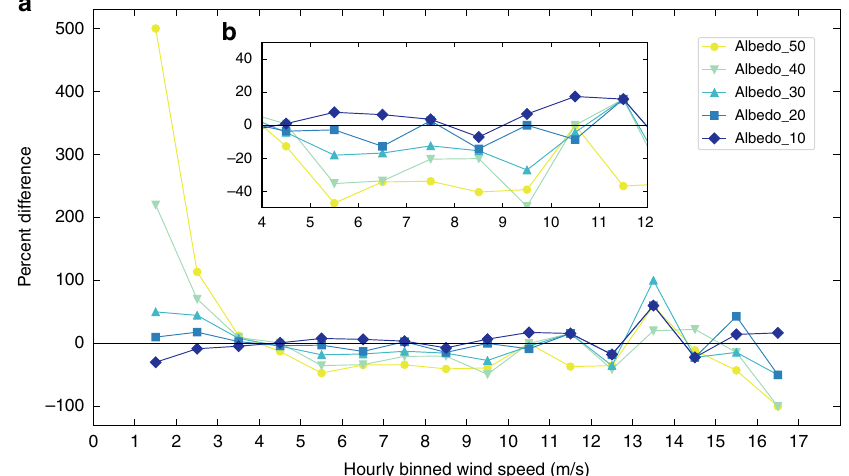
Fig. 5 Percent difference of wind speed frequencies between the albedo simulations and control. a The percent difference of spring (March, April, and May) 2011 hourly 10-m wind speed frequency (averaged for the entire Hami Basin) for each albedo simulation from the control simulation (WRF_Control). The binned data are from Fig. 4. b Same at a , but with reduced x - and y -axes limits to show small variation between model